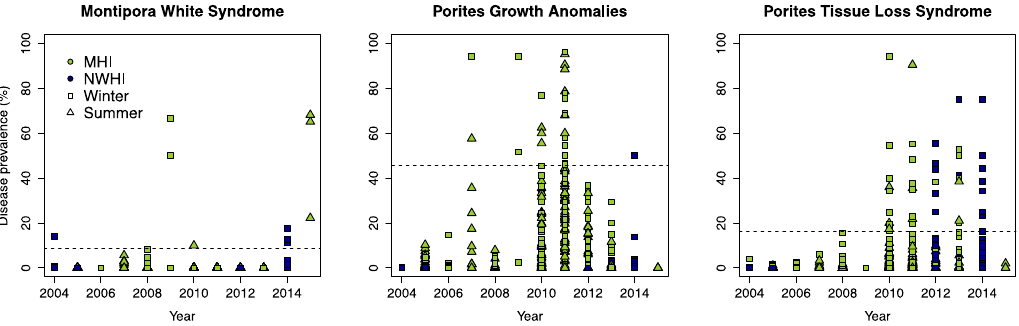
Figure 2. Disease prevalence by disease, year, season and region. Scatterplots of Montipora white syndrome, Porites growth anomalies and Porites tissue loss syndrome prevalence through time. Dashed horizontal lines represent outbreak thresholds determined by the iterative analysis described in the methods. MHI: Main Hawaiian Islands; NWHI: Northwestern Hawaiian Islands. Winter includes surveys conducted in November–April; summer includes surveys conducted in May–October.